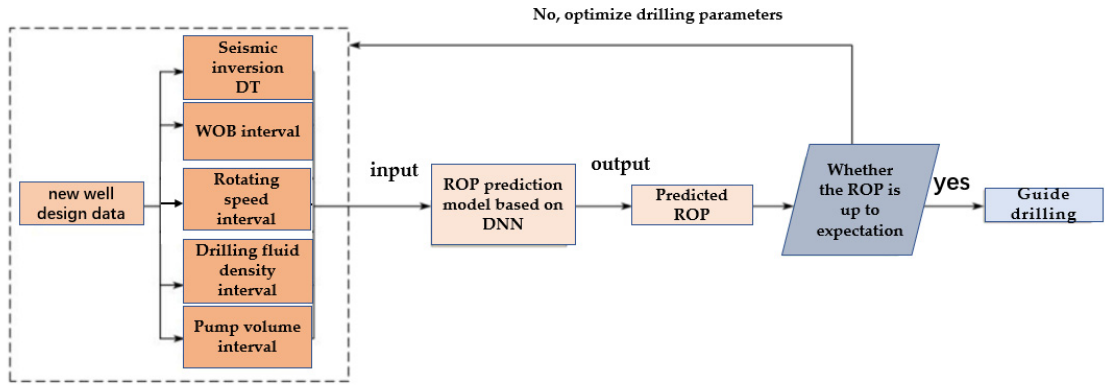
Figure 20. Optimization process of drilling parameters.